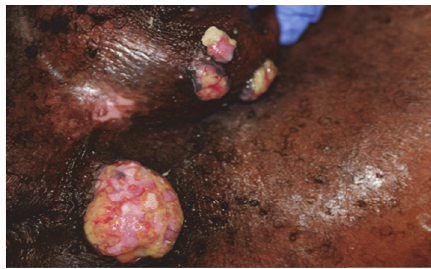
Figure 1: Appearance of tumorous lesions on the scrotum and perineum on admission.